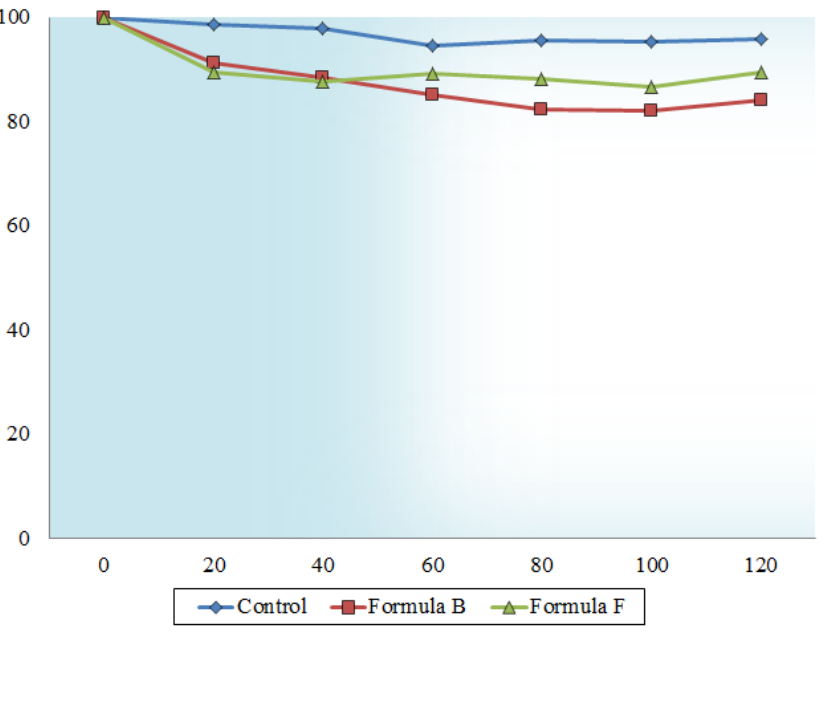
Figure 4. The transepithelial electrical resistance (TEER) of excised rat intestinal tissue treated with microsphere formulations B and F as well as control group plotted as a function of